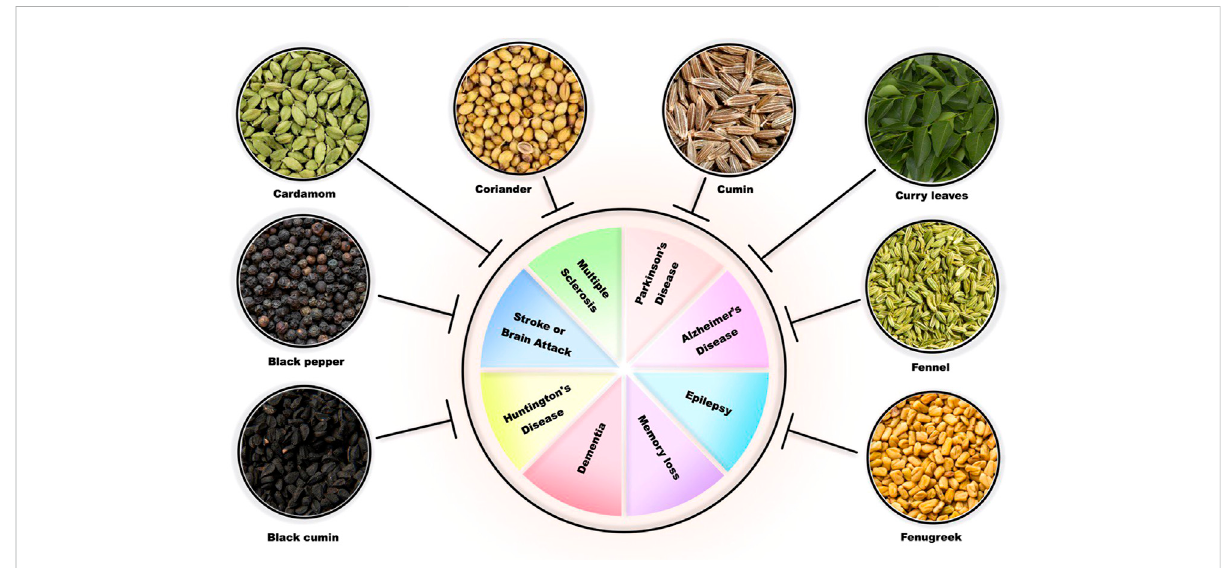
FIGURE 1 Potential of common Indian spices in ameliorating neurodegenerative